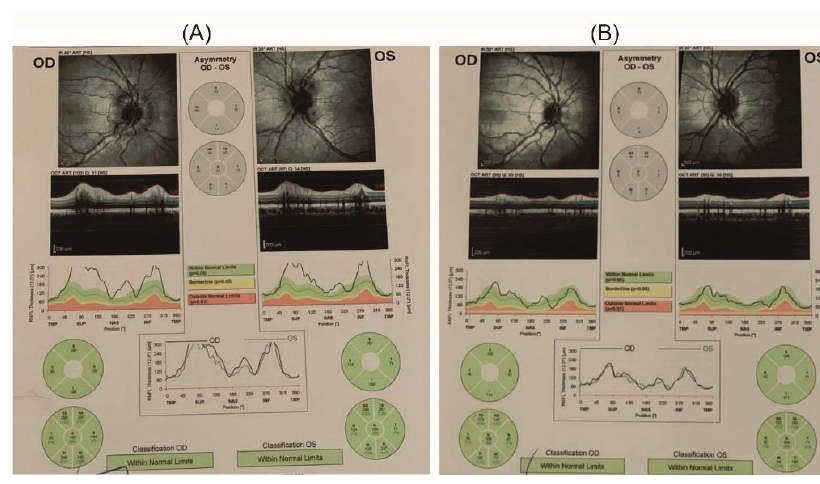
Figure 2. (A): Peripapillary nerve fiber edema in RNFL OCT, (B): After medical treatment, RNFL thickness significantly